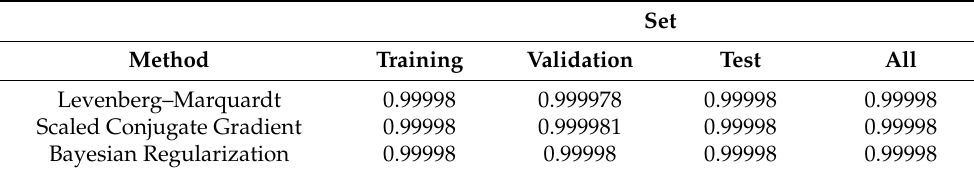
Table 5. Circles error measures ( r )— x position.